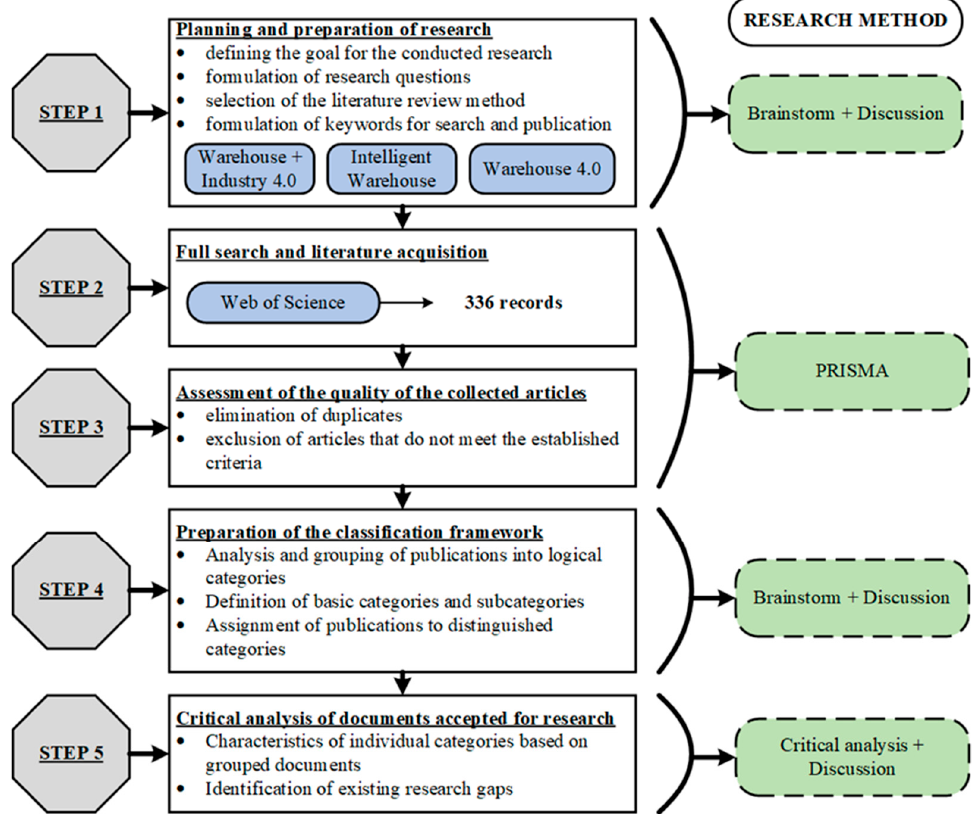
Figure 2. Stages of the research procedure.